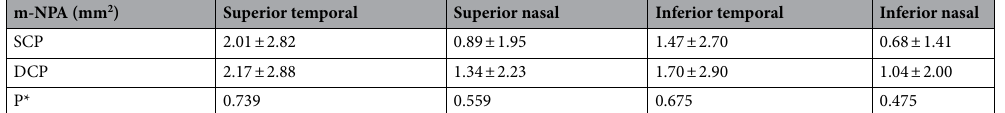
Table 2. Comparison of the mean m-NPA in each area of the SCP and DCP on OCT angiography. Values are presented as means ± standard deviation. m-NPA macular non-perfused area, OCT optical coherence tomography, SCP superficial capillary plexus, DCP deep capillary plexus. *P value by unpaired t test.